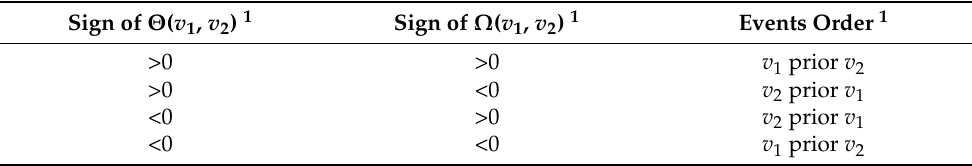
Table 2. Sequential order of changes for a couple of correlated vibrational modes according to Noda’s rules. Sign of Θ ( v 1 , v 2 )